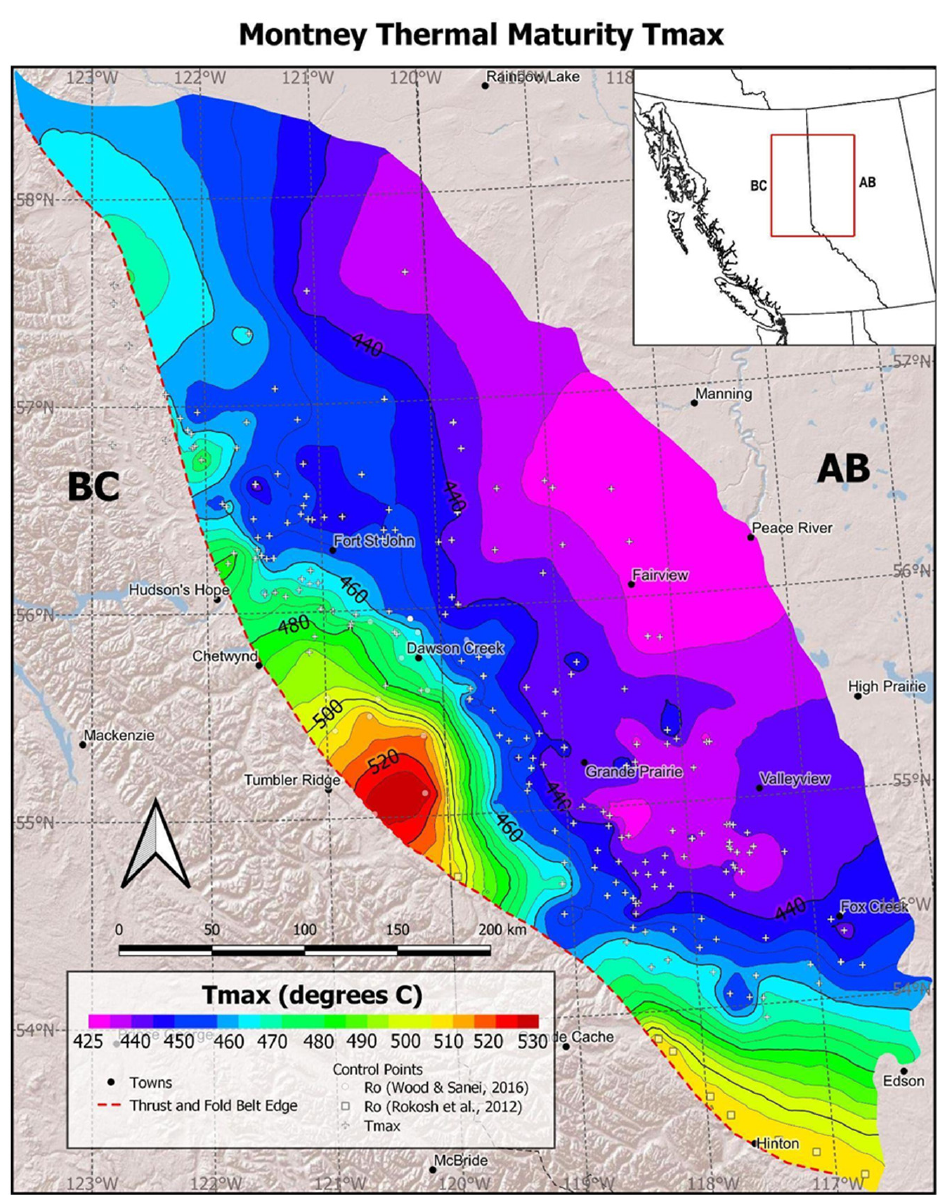
Figure 7. Distribution of the thermal maturity indicator, Tmax, for the Montney Formation. Changes in the maturation trends within the Fort St. John area (to cooler blue colours and lower maturity) are due to the Fort St. John Graben structures (see Figure 1) impacting the maturation process.